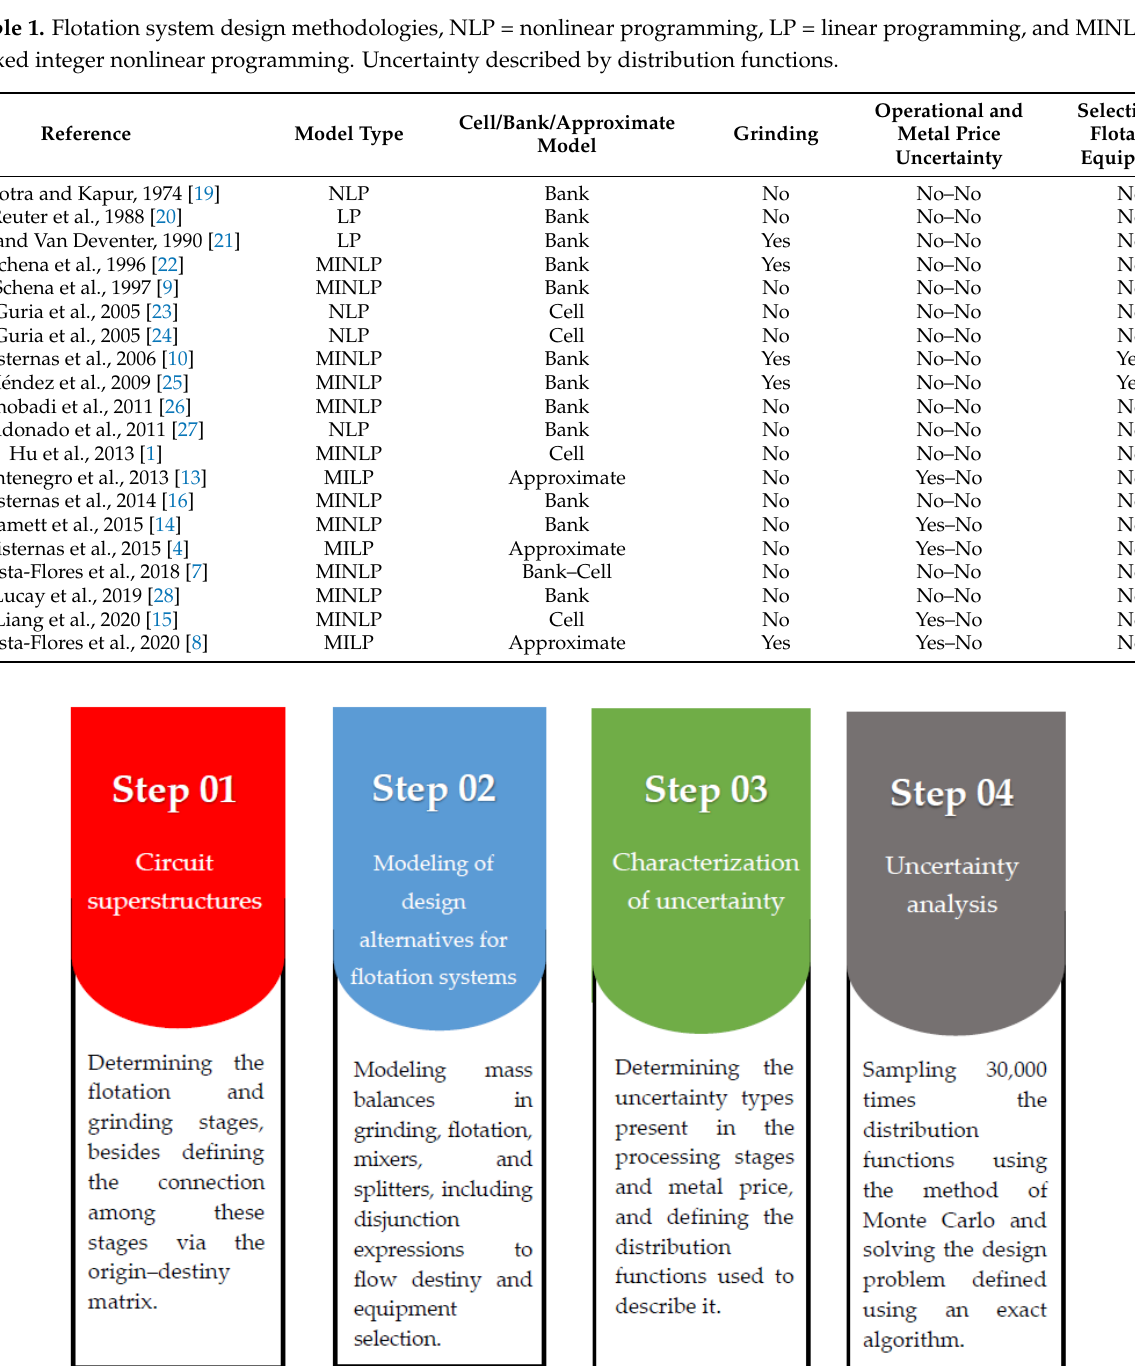
Figure 1. The methodology employed to prove the hypotheses.